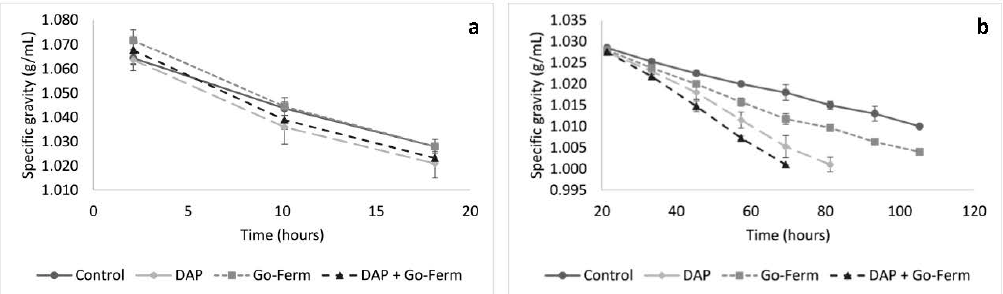
Figure 2. Cell Viability during yeast acclimatization. Mean concentration of viable cells during the adaptation stage 2 ( a ) and proliferation stage 3 ( b ) were measured and recorded as units of 10 8 cells / mL (a) or 10 7 cells / mL (b) Error bars represent the standard deviation of n = 4 replicates.